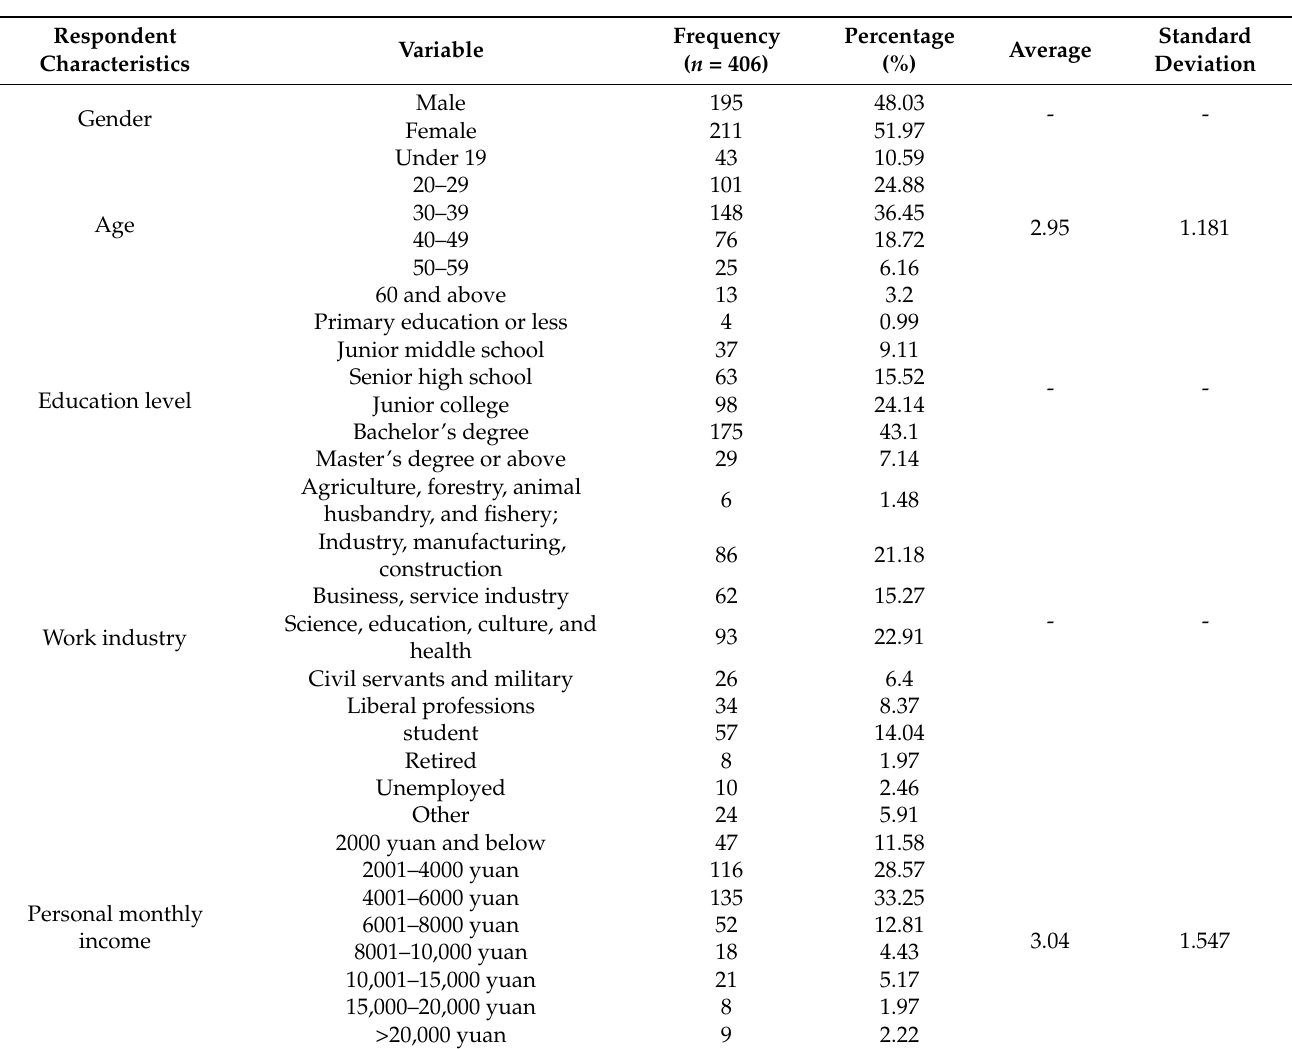
Table 2. Demographic characteristics of the tourist sample ( n =